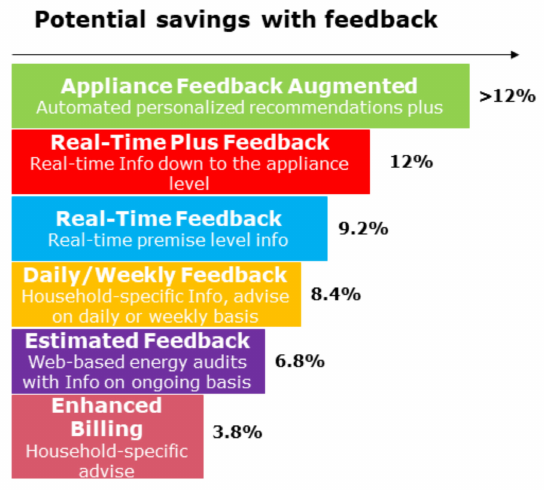
Figure 1. Graphical representation of independent studies analyzed by [3] about residential savings resulting from di ff erent types of consumption